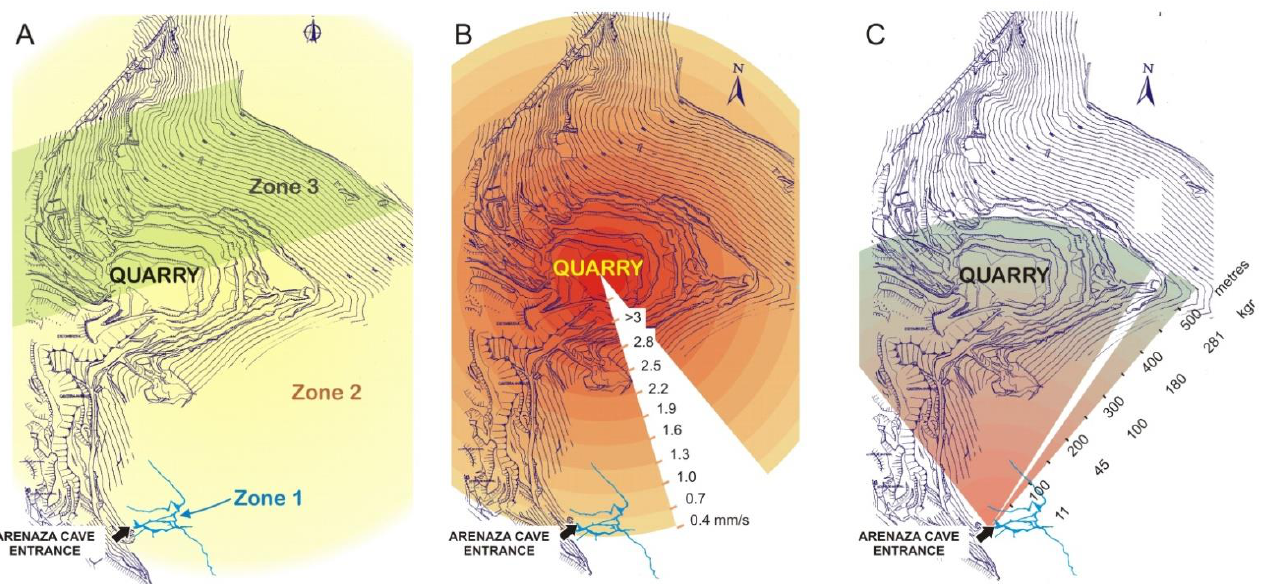
Figure 3. Influence of nearby mining activity in the Arenaza cave area. ( A ) Levels of protection areas defined in the Arenaza Cave archaeological site. ( B ) Map of isolines showing the vibration velocity produced by controlled explosions from the quarry area near the cave. ( C ) Map of isolines that indicate the maximum calculated admissible explosive charges so that the vibrations in the “Paintings Sanctuary” are less than 0.5 mm/sec.